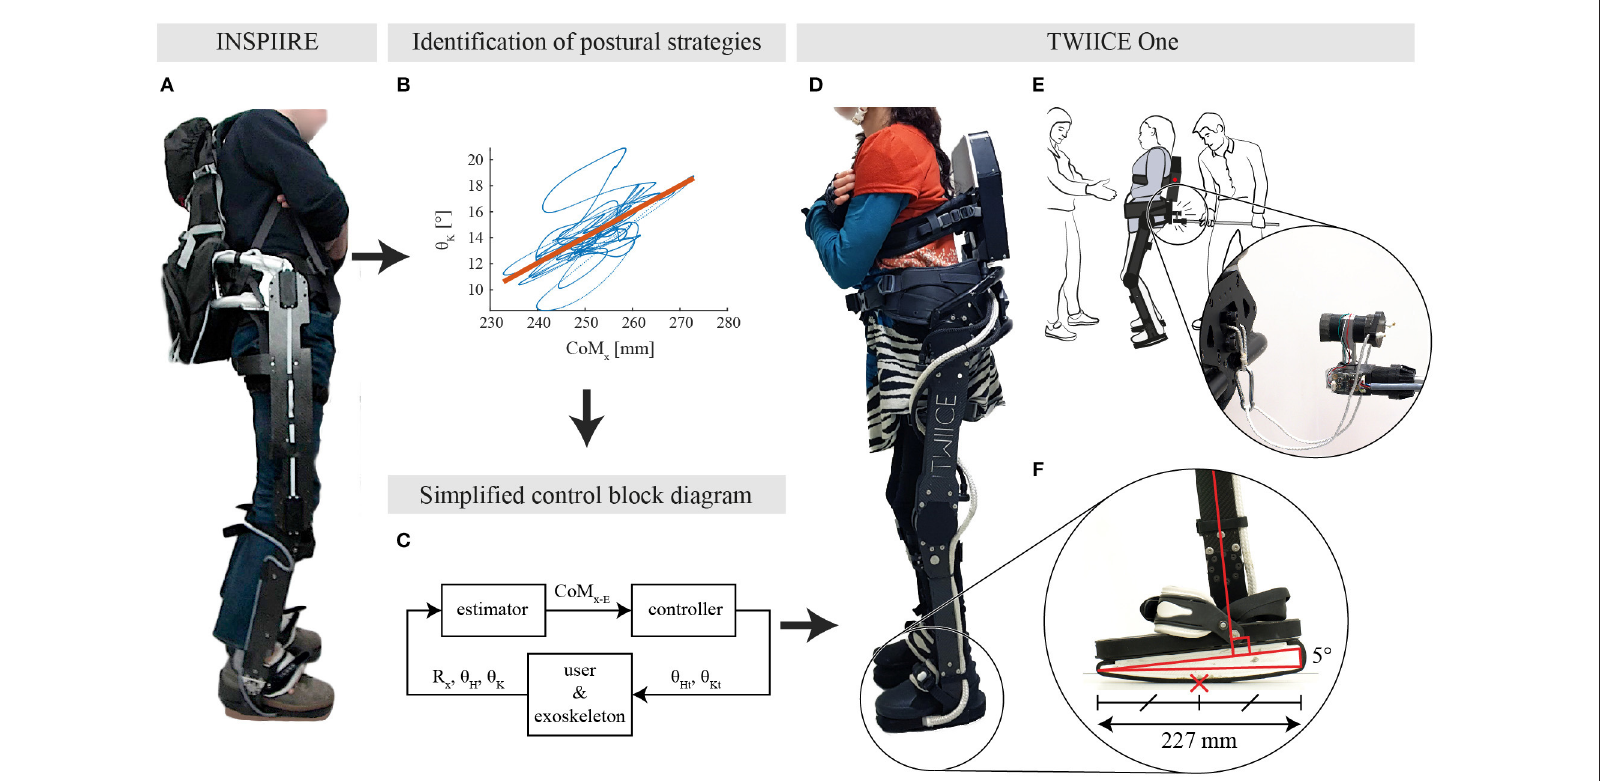
FIGURE 1 | (A) Healthy participant standing while being constrained by INSPIIRE, a passive exoskeleton. (B) Identified relation between the knee angle and the CoM x for a typical young healthy participant in the eyes closed condition from Fasola et al. (2019). (C) Overview of the controller block diagram. CoM x − E is the estimated projection of the center of mass, R x represents the foot angle with respect to the ground line, while θ H and θ K are the hip and knee angles, respectively. (D) TWIICE running with the knee controller (BKC) and a complete SCI user. (E) Overview of the experimental setup, with the experimenter in the back, and the spotter in front. The experimenter interacts with the exoskeleton through the instrumented stick. (F) Close-up view on the TWIICE foot, with the rounded sole and the 5 ◦ wedge. The red cross is the position of the CoP, at the middle of the foot in this case. This is considered as the “horizontal” position of the